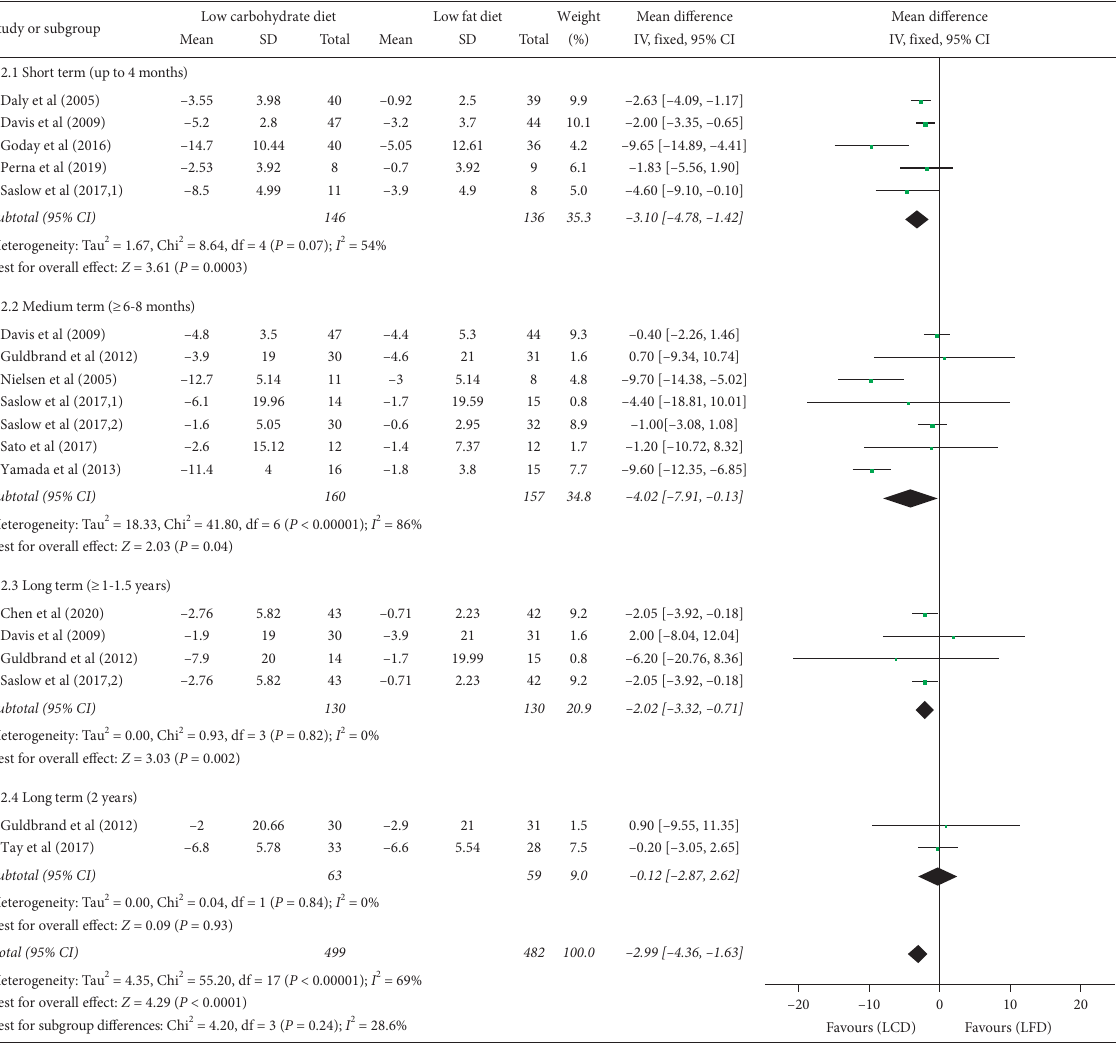
Figure 4: Forest plot for the effect of restriction diets on body weight loss. LCD: low-carbohydrate diet; LFD: low-fat diet; CI: confidence interval; SD: standard